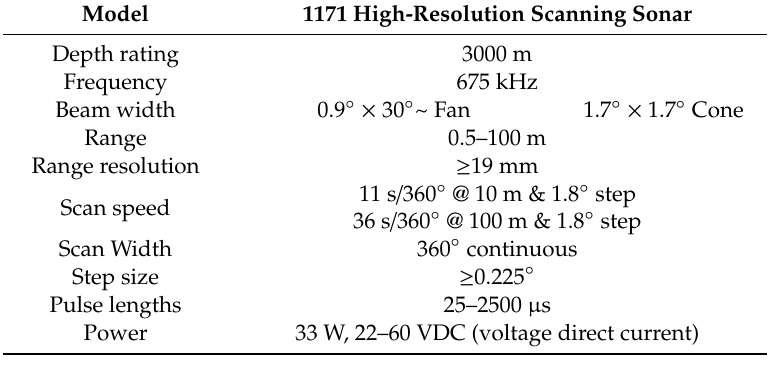
Figure 1. General sector-scanning sonar image acquisition methods: ( a ) Horizontal image acquired by tripod deployment; ( b ) Vertical image acquired by pole-mount deployment. Table 1. Specifications of sector-scanning sonar.